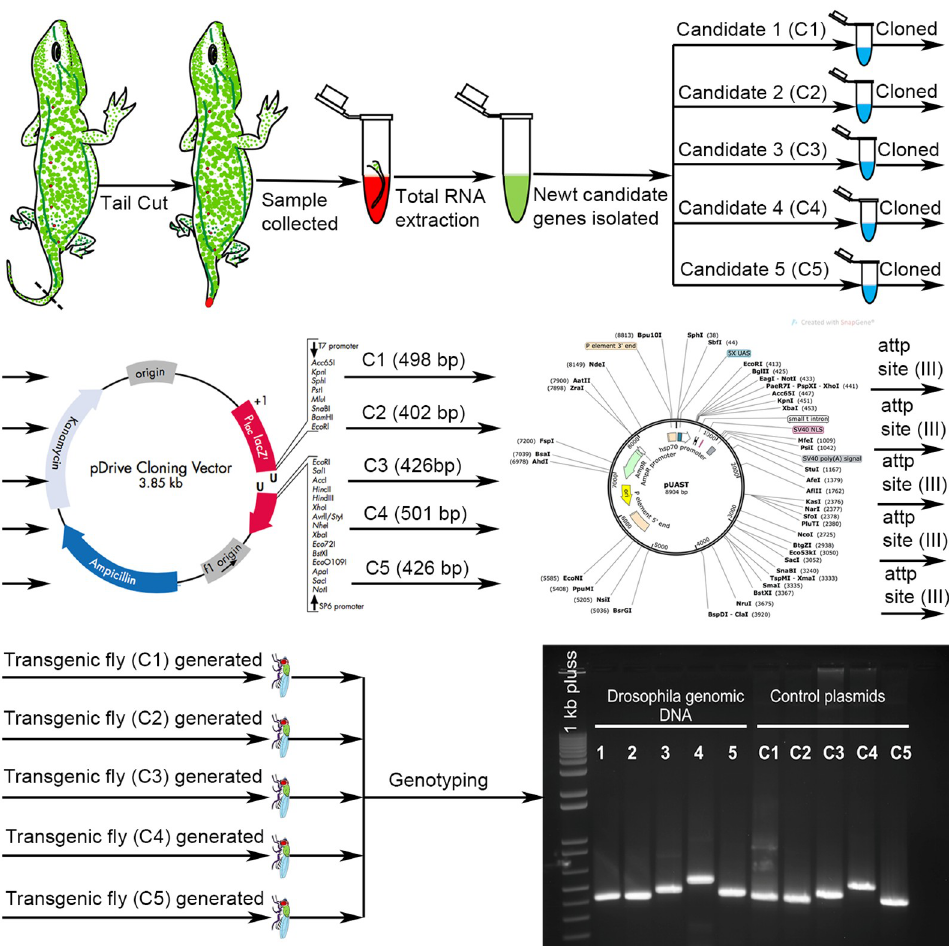
Fig 2. Schematic representation of generation of transgenic Drosophila. Novel Newt candidate genes were used to create 5 transgenic flies. Each fly had a single copy of newt candidate gene (C1, C2, C3, C4 or C5) inserted at chromosome III. After generating transgenic flies, genotyping was performed to check if Newt genes have been properly incorporated in Drosophila genome.